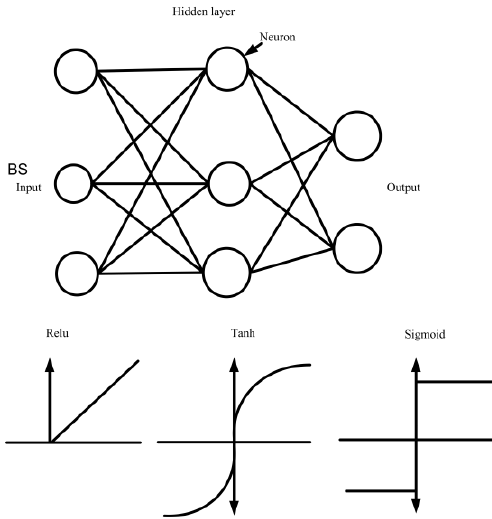
Figure7. Optimal Power Allocation using DNN and DLS